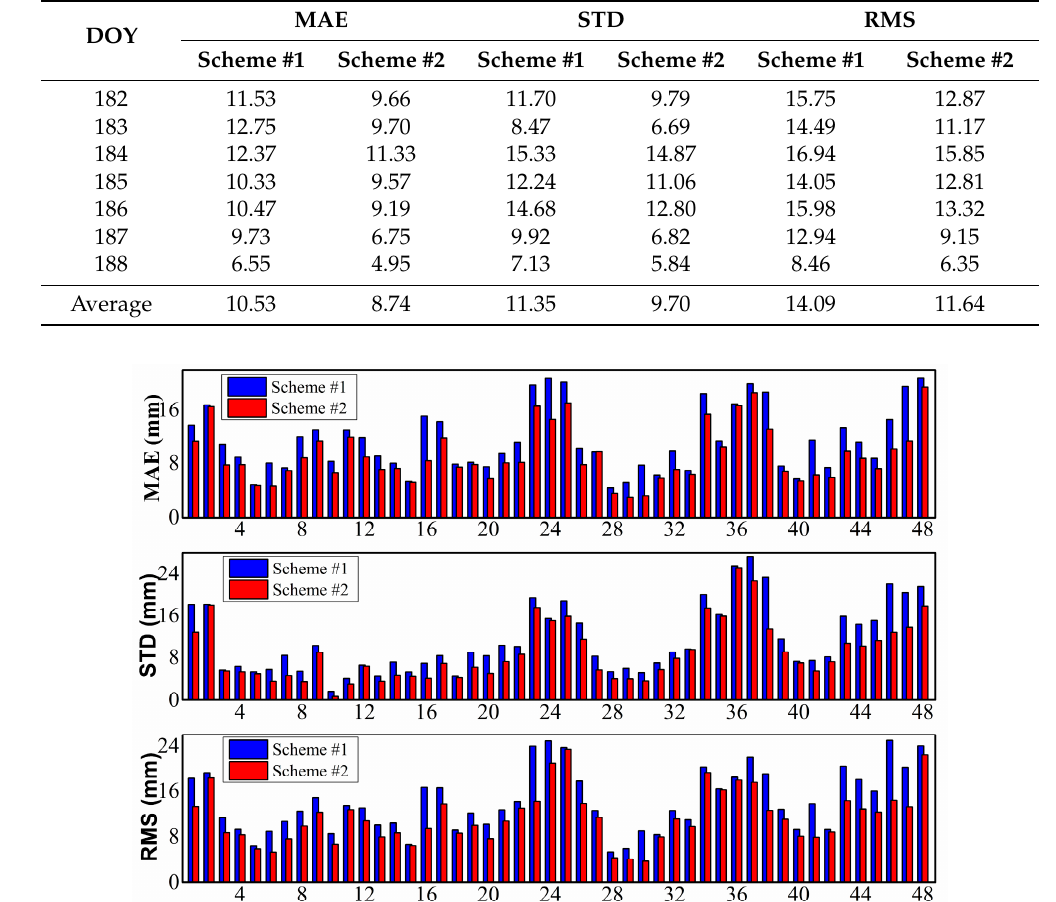
Table 4. Accuracies in terms of MAE, STD, and RMS using two schemes for 7 days (Unit: mm).